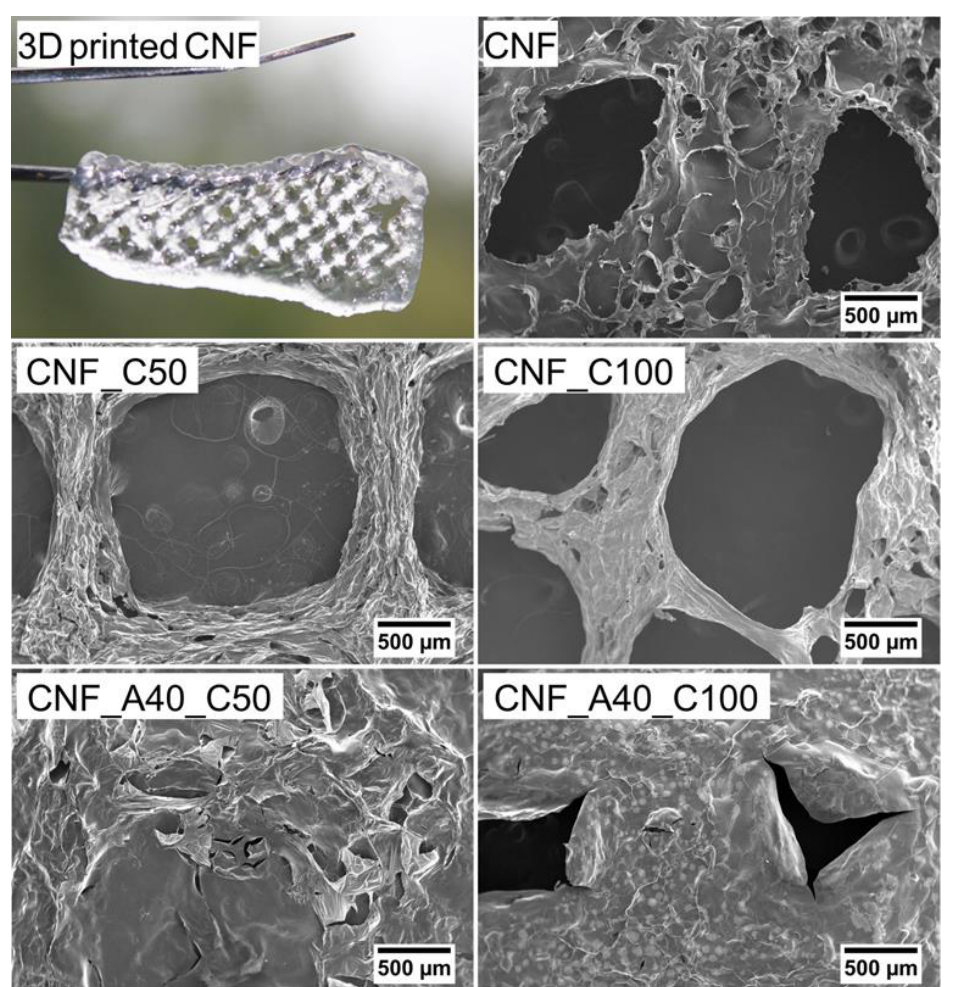
Figure 3. A 3D printed CNF wound dressing cross-linked with CaCl 2 (CNF_C50), and Scanning Electron Microscope (SEM) images of a region of five freeze-dried 3D printed constructs. The target dimension of the 3D printed CNF structure (upper left) was 20 mm × 40 mm.